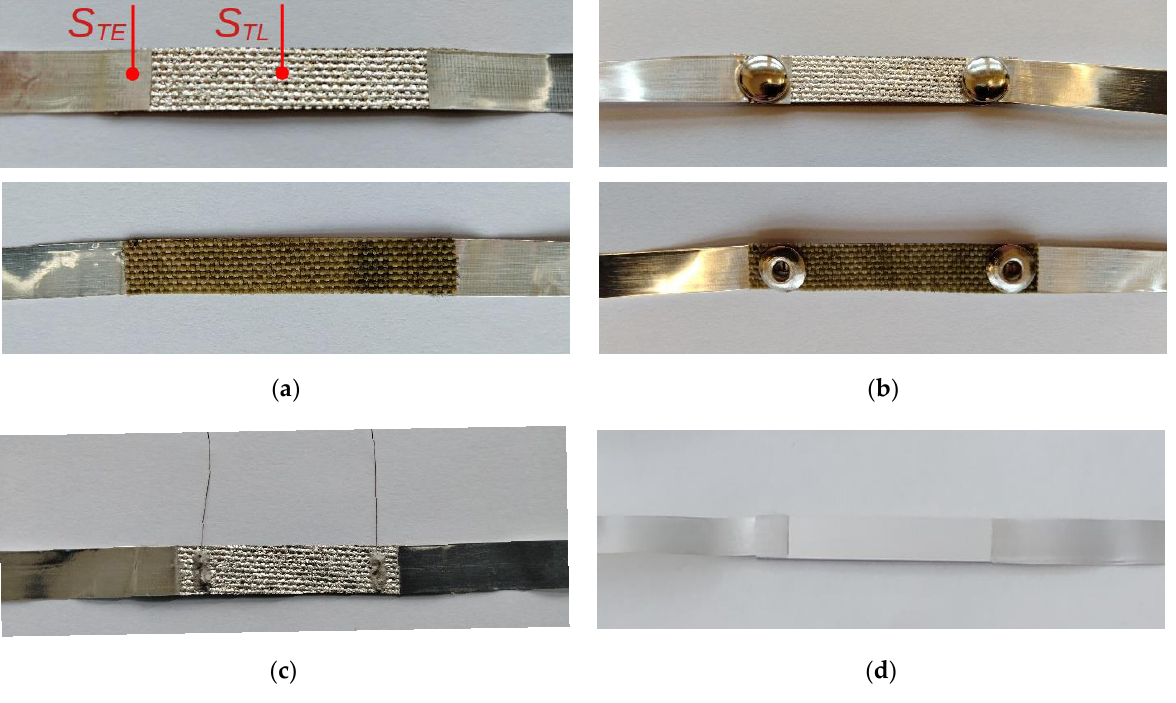
Figure 1. Front and back views of samples with current leads and temperature sensors: ( a ) gluing, S TE — position of the electrode temperature sensor (or connections), S TL — position of the layer tem- perature sensor (sample G + T); ( b ) crimping (sample C + T); ( c ) wire voltage electrodes (sample M + T); ( d ) sample S + C.